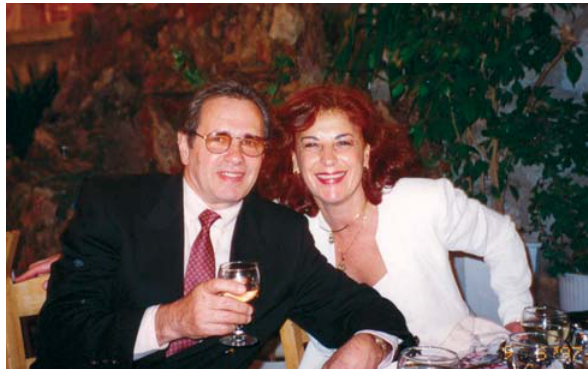
Fig.1 – Dr. José Carlos de Andrade e a esposa Isabel (Bela) Bastos de Andrade